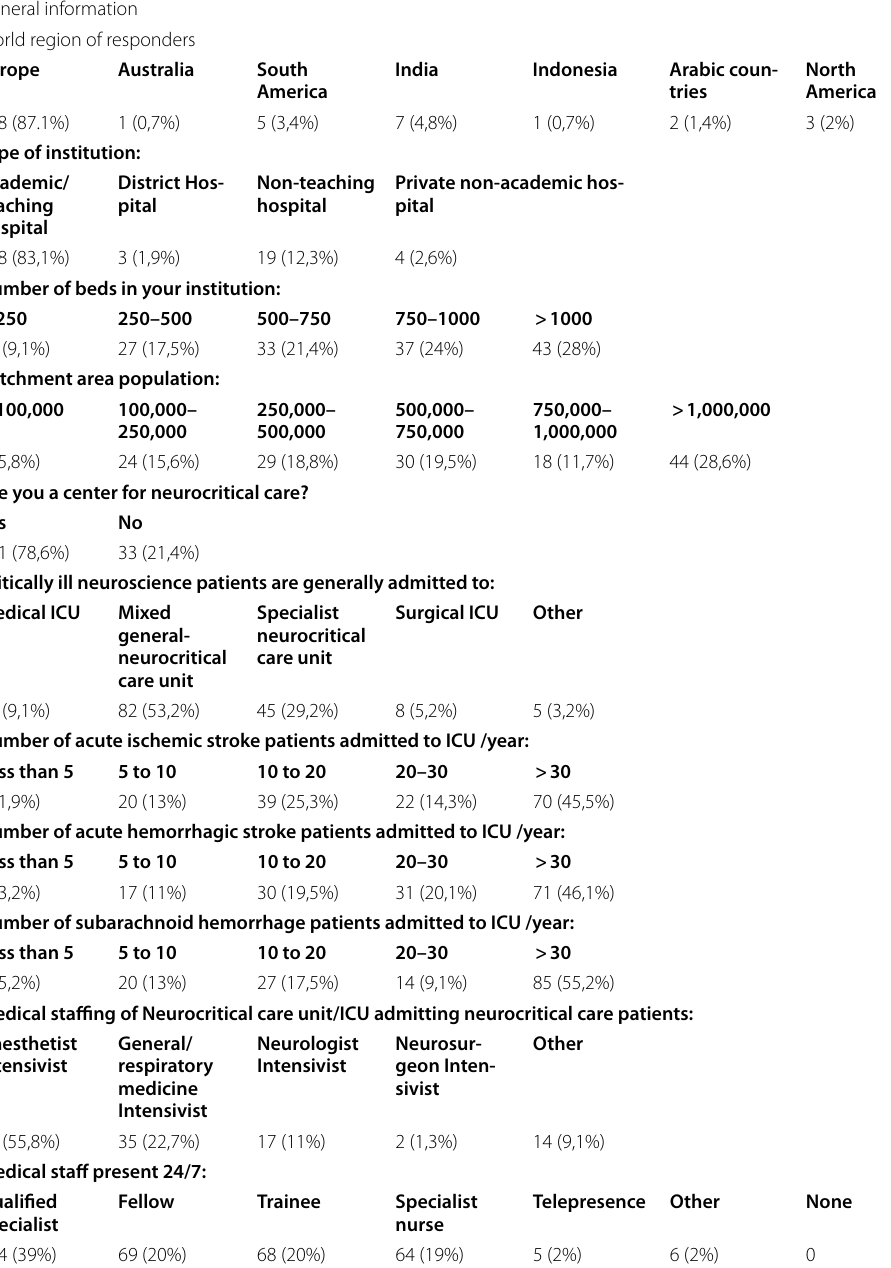
Table 1 General characteristics of participants General